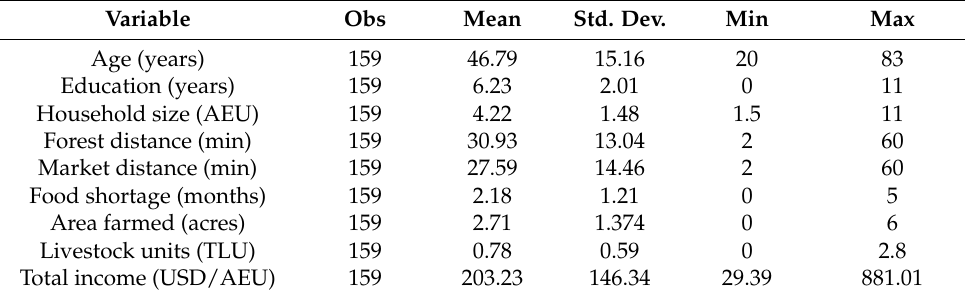
Table 2. Descriptive statistics of the study